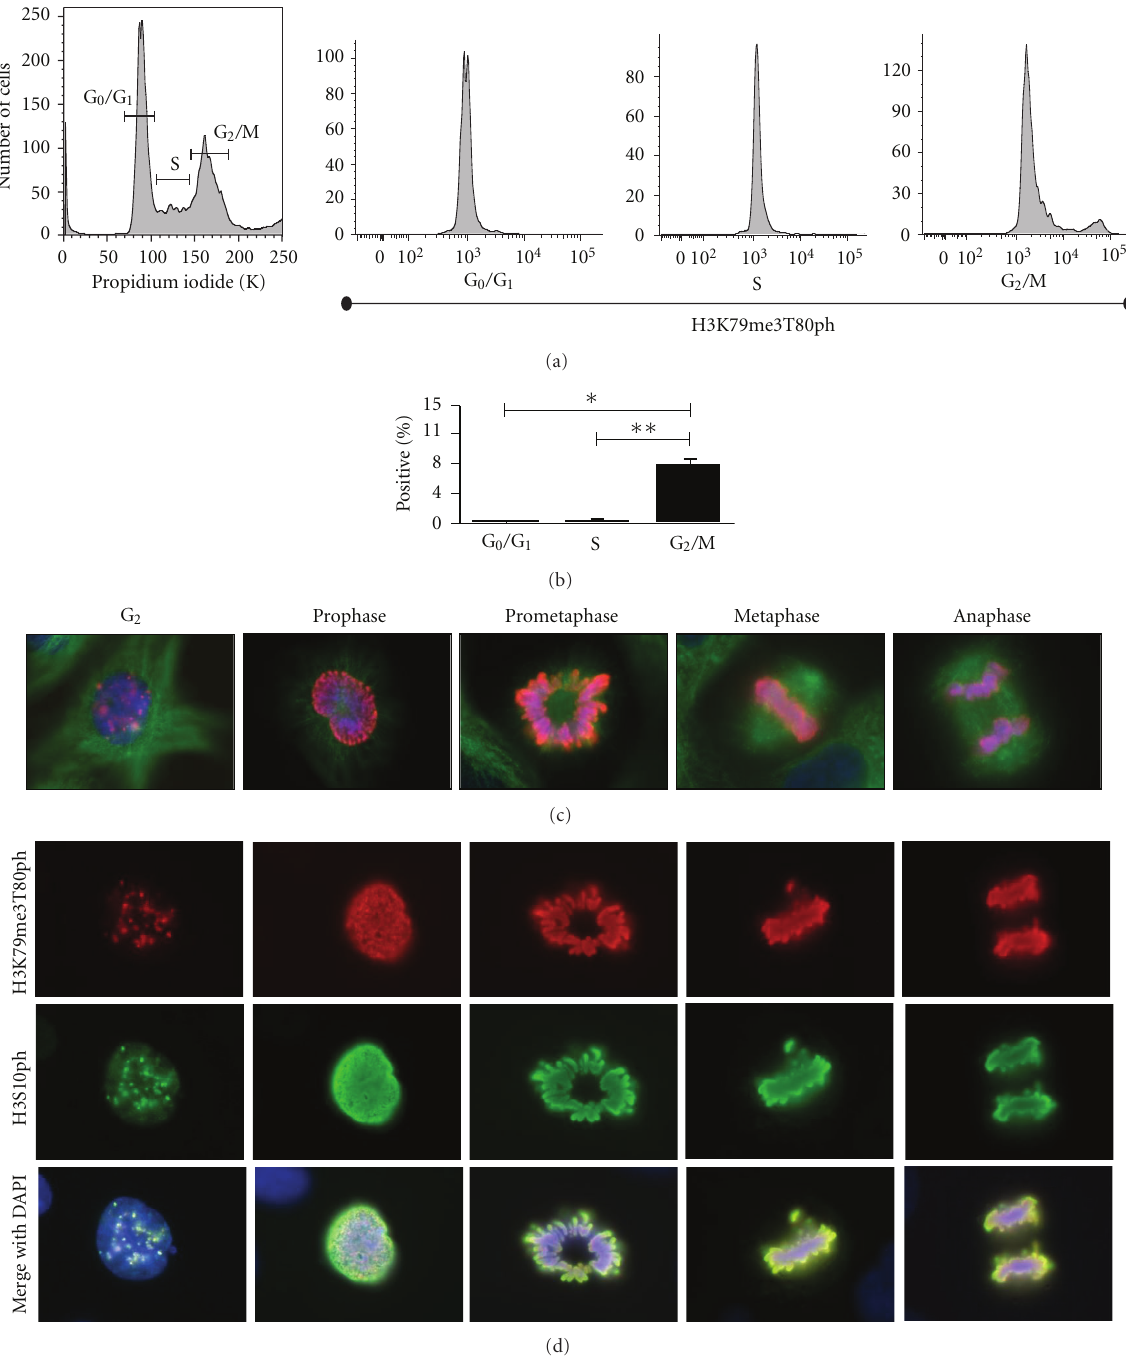
Figure 3: H3K79me3T80ph is mitosis-associated. (a) Representative flow cytometry experiment of untreated asynchronous HeLa cells stained with propidium iodide and H3K79me3T80ph (Area). Propidium iodide incorporation was used to obtain a cell cycle profile, and the cell cycle phases were then gated. An H3K79me3T80ph histogram was created for each phase of the cell cycle. (b) Percentage of H3K79me3T80ph positive cells in each cell cycle phase as determined by flow cytometry of asynchronous HeLa cells stained with propidium iodide and H3K79me3T80ph (Area). Bars represent mean values ( ± S.E.M.), n = 3; ∗ p G (C) Immunofluorescence of asynchronous UCD-Mel-N cells stained for H3K79me3T80ph (red), tubulin (green), and DNA (blue). (d) H3K79me3T80ph and H3S10ph co-immunofluorescence performed on asynchronous UCD-Mel-N cells; H3K79me3T80ph (red), H3S10ph (green), DNA